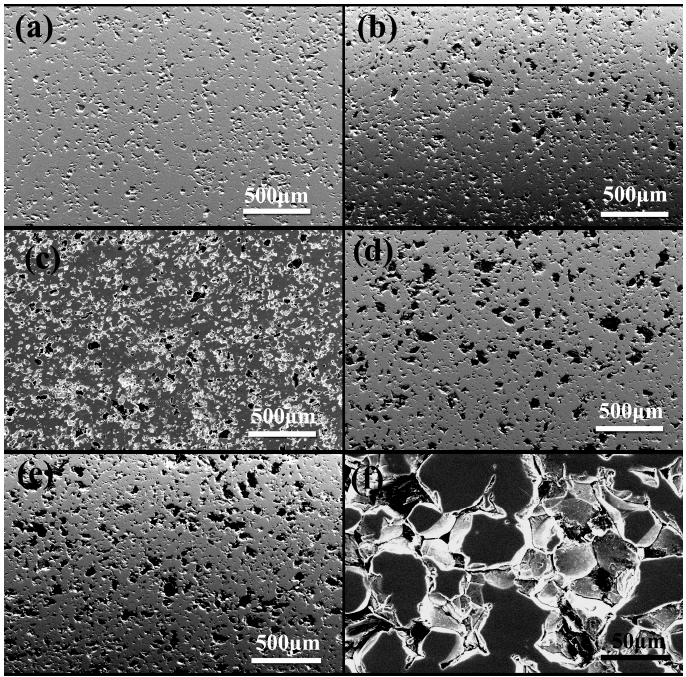
Figure 2. Surface microstructure of: ( a ) BMG; ( b ) BMG-1 wt % graphite; ( c ) BMG-2 wt % graphite; ( d )BMG-3 wt % graphite; ( e ) BMG-4 wt % graphite; ( f ) BMG-4 wt % graphite at high magnification.